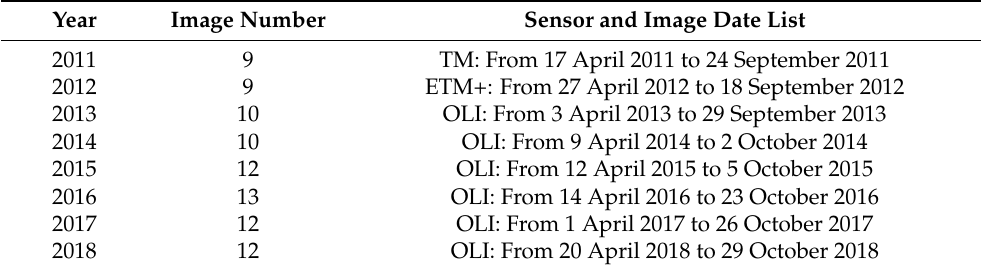
Table 1. The information of using Landsat images (from April to